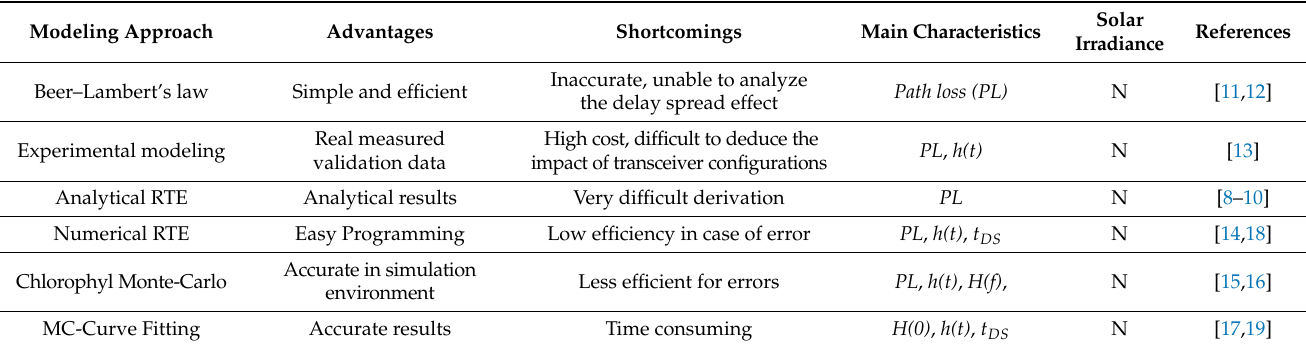
Table 1. Summary of UOWC (underwater optical wireless communication) channel modeling approaches of previous works. Modeling